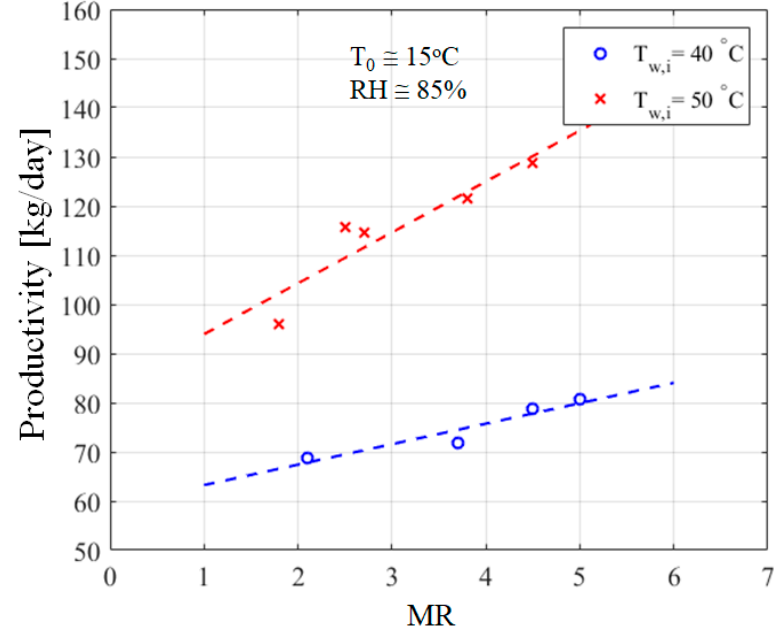
Figure 5. Productivity as a function of mass ratio ( MR ).